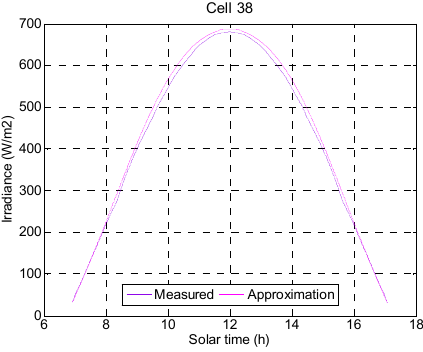
Figure 6. Comparison of radiation results for one day data and continuous measurements using Equation (4).